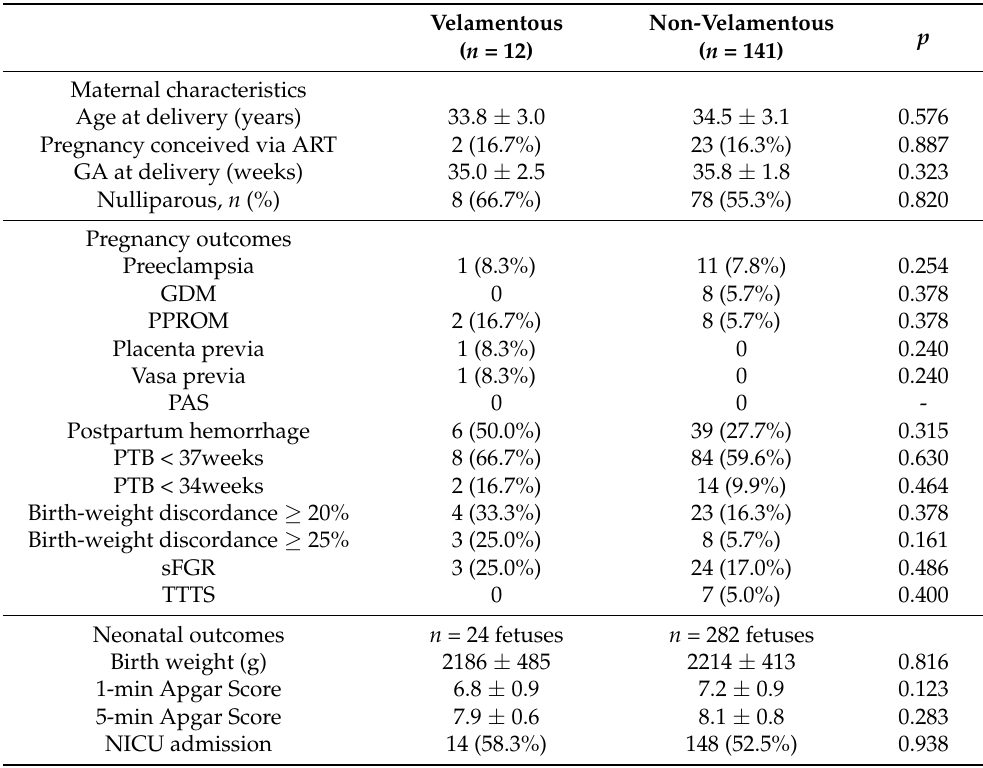
Table 4. Comparison of maternal characteristics and perinatal outcomes in monochorionic diamniotic twin pregnancies according to velamentous cord insertion ( n =